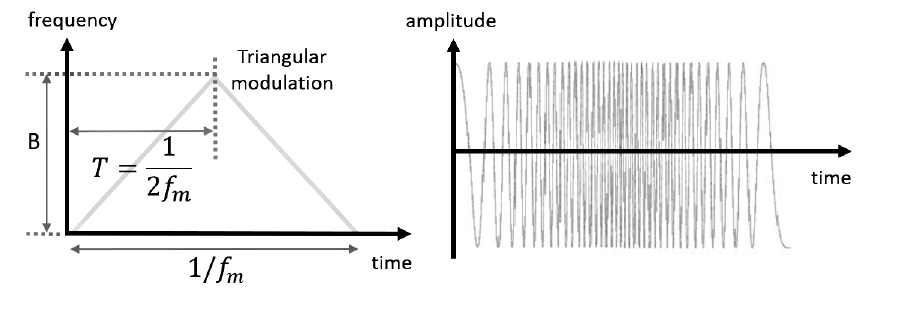
Figure 4. Triangular frequency modulation with time and linked amplitude signal change in the time domain.